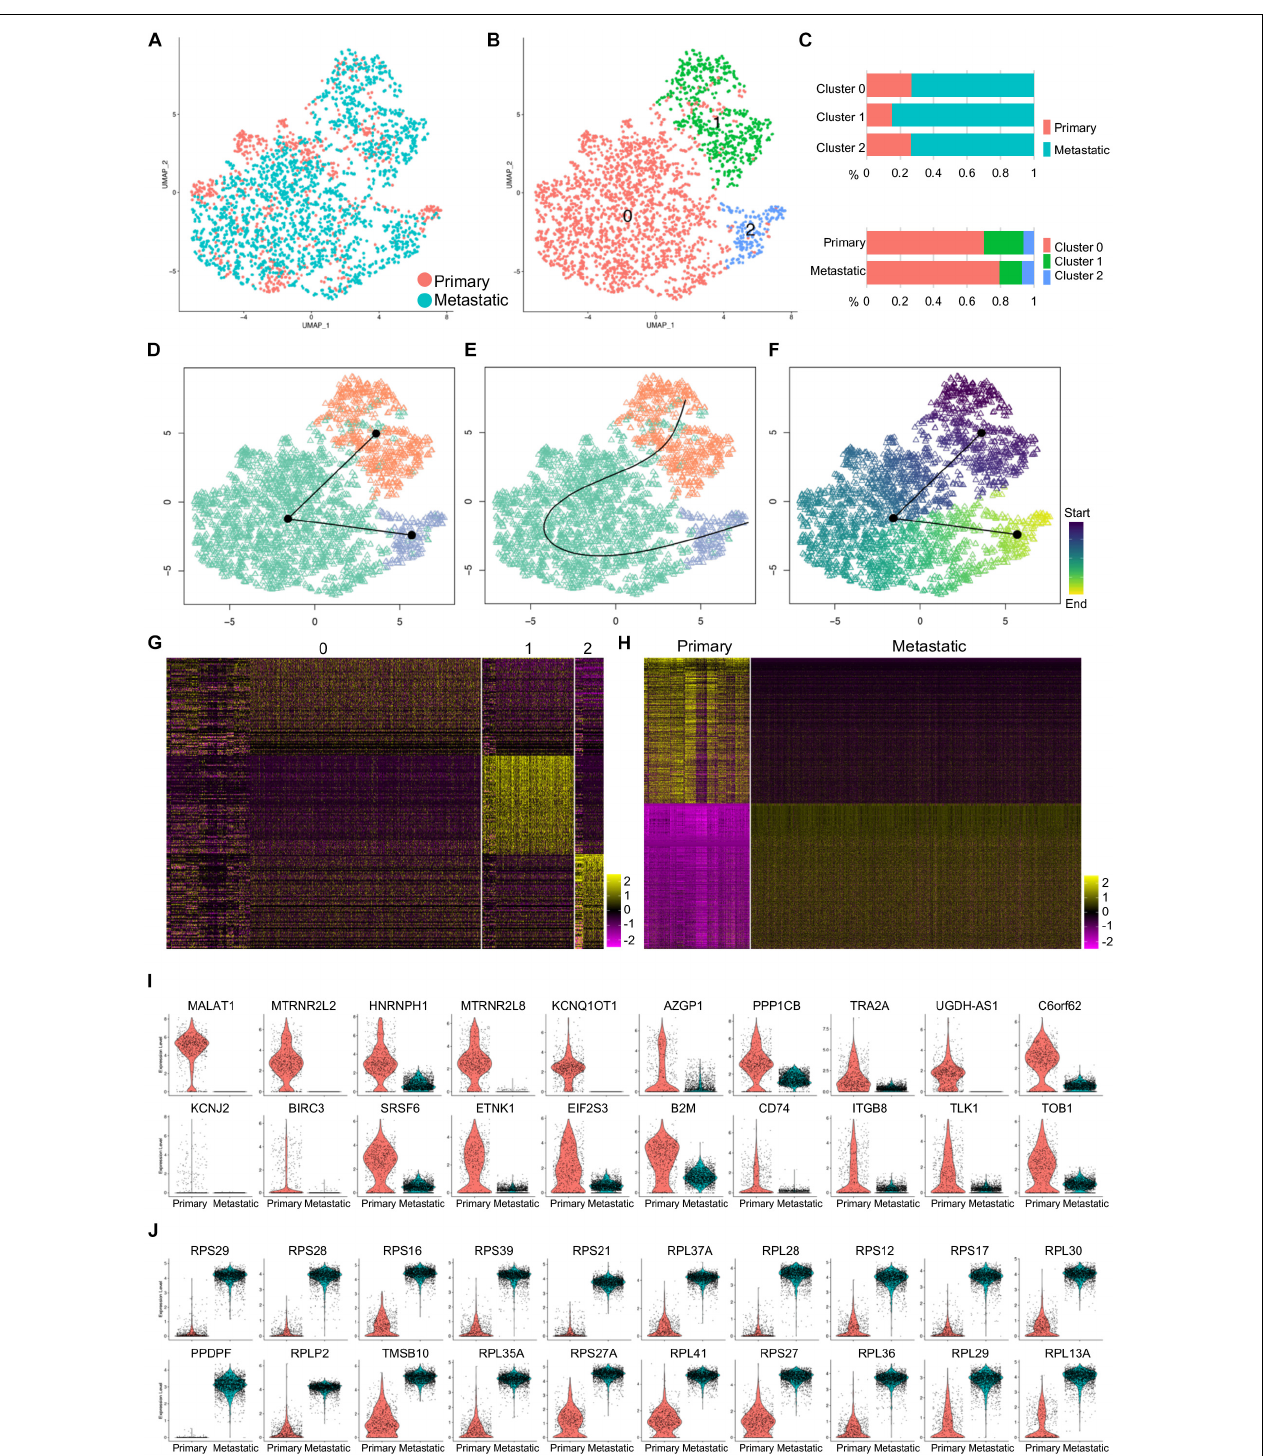
FIGURE 3 | Gene expression patterns of primary and metastatic cancer cells of human TNBC cells. (A) Purified primary and metastatic cancer cells were integrated, and UMAP showed cell distribution. (B) Cells were clustered, and three clusters were identified. (C) The cell percentage of primary and metastatic cancer cells in each cluster and the cell percentage of each cluster in primary and metastatic cancer cells were quantified. (D,E) Slingshot analysis identified the inferred trajectory (D) and principal curves (E) of the cancer cell clusters. (F) Pseudotime analysis for the cancer cell clusters was visualized by UMAP. (G,H) Heatmap visualization of the top 100 genes of each cancer cell cluster (G) and top 500 genes of the primary and metastatic cancer cells (H) . (I,J) The violin plot showed the top 20 genes upregulated in primary (I) or metastatic (J) cancer cells.